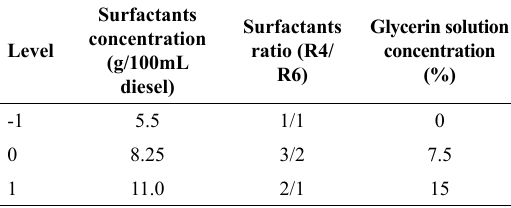
Table 3. Factors and levels used in experimental design